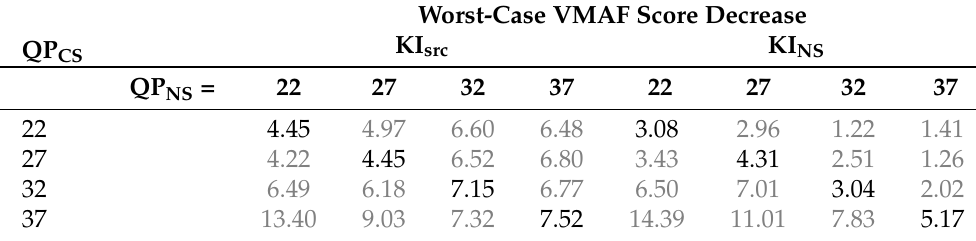
Table 6. Worst-case decrease in VMAF